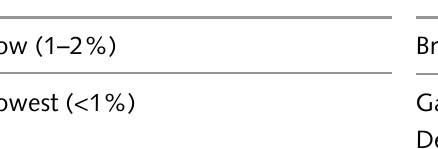
Table 1. Classification of countries according to CSOM prevalence Group Highest (>4%) – urgent attention needed to deal with a massive public health problem High (2–4%) – avoidable burden of disease must be addressed